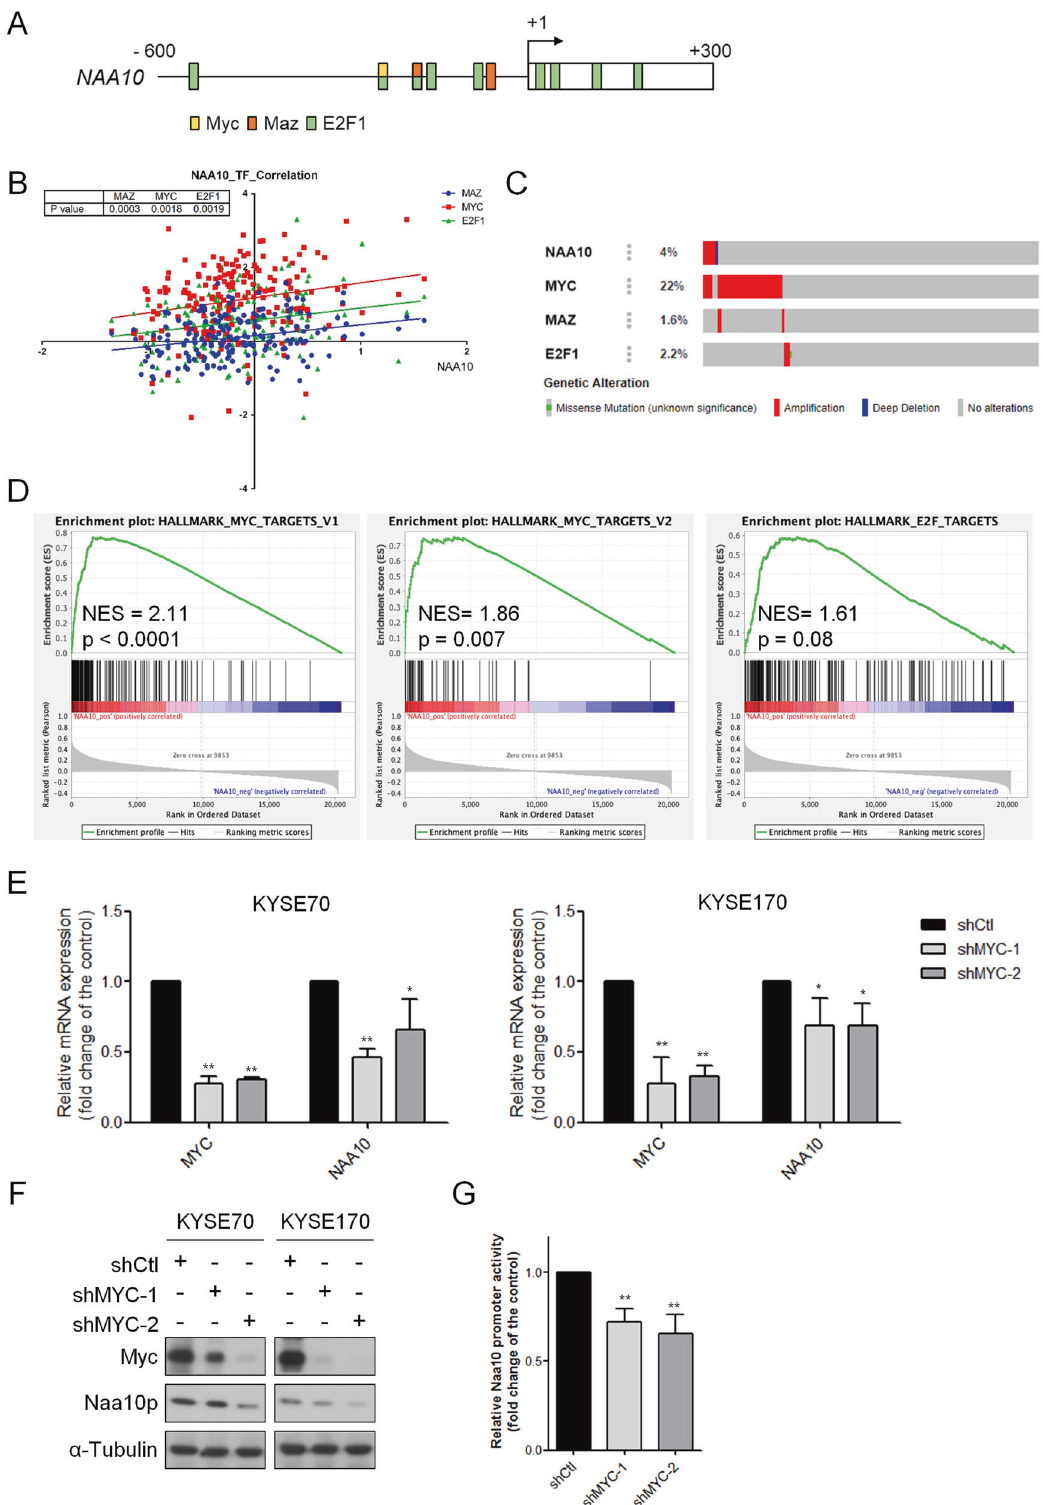
Fig. 2 NAA10 expression in ESCA was regulated by oncogenic c-Myc. A Predicted binding motifs of transcription factors on NAA10 promoter region in UCSC genome browser. B Correlation plot comparing RNA levels of transcription factors ( MYC , MAZ , and E2F1 ) and NAA10 in TCGA. C Gene alteration frequencies of NAA10 , MYC , MAZ , and E2F1 in ESCA from TCGA database. D GSEA analysis identi fi ed the MYC signatures among the top ranked activated pathways in NAA10 -high ESCA patients (TCGA). E NAA10 expression in MYC-knockdown KYSE70 and KYSE170 were detected by qPCR. F Naa10p expression in c-Myc knockdown KYSE70 and KYSE170 were detected by Western blot. G c-Myc-depleted KYSE70 cells and control cells were transfected with NAA10 reporter and subjected to luciferase activity assays. GSEA gene set enrichment analysis, NES normalized enrichment